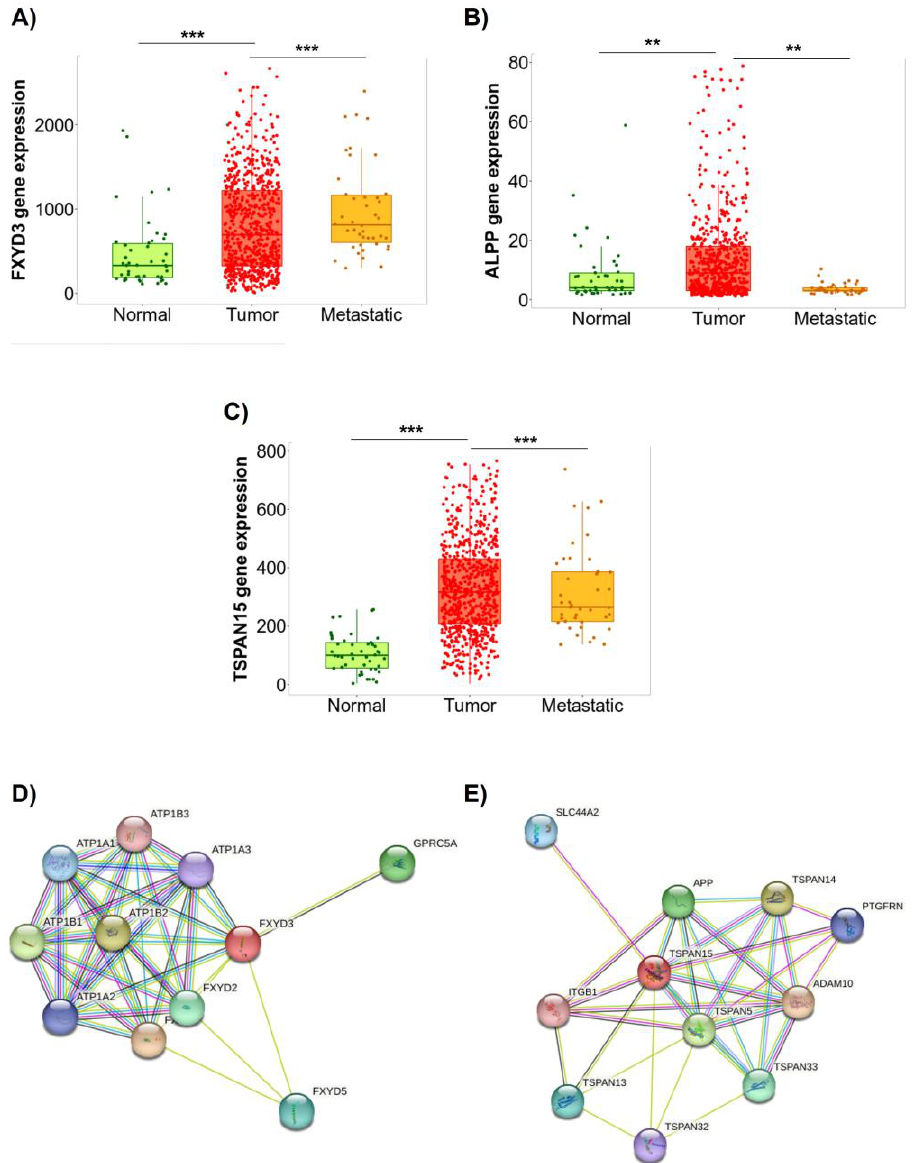
Figure 10. Gene expression profile of the selected targets in ovarian cancer and PPI network analysis. Samples from ovarian cancer patients comparing normal, primary site tumor, and metastatic tissues from genetic chip data available in the TNMplot database for ( A ) FXYD3, ( B ) ALPP, and ( C ) TSPAN15. The y axis represents mRNA expression, and the x axis represents the studied groups. The main signaling pathways were triggered by ( D ) FXYD3 and ( E ) TSPAN15 in ovarian cancer by STRING database. (**) indicates p value <0.05. (***) indicates p value < 0.001.